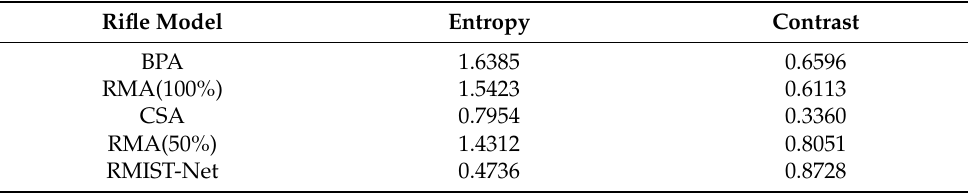
Table 4. Quality evaluation of imaging results in different